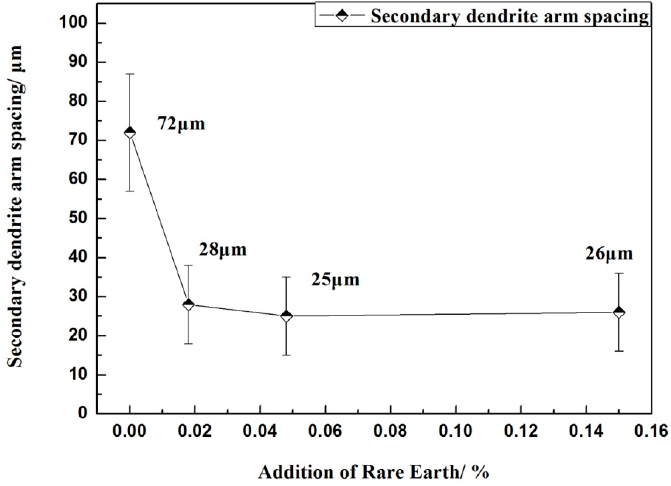
Figure 2. The secondary dendrite arm spacing of the specimens as-casted with different additions of RE.